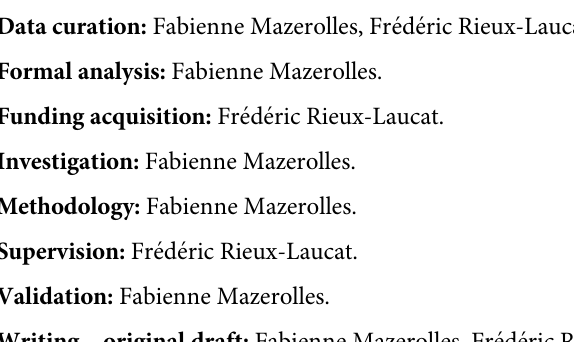
control (Iso) is shown for each protein (grey lines). Bars represent the means of all experiments for each proteins. (TIF) S5 Fig. TIGIT expression on activated T cells. A) Representative flow cytometry dot plots for cell proliferation on D5 of the co-culture. CTV-stained TEFFs were co-cultured with DCs-SEE in the absence (TEFFa) or the presence of CFSE-stained TREGs (TEFFb) with a TEFF:TREG ratio of 2:1. B) Representative histograms of TIGIT expression (solid black lines) on gated CTV-stained TEFFs in the absence of TREGs (TEFFa) or in the presence of TREGs (TEFFb) and on gated CFSE-stained TREG (TREGs). The TEFF:TREG ratio was 2:1. The isotype con- trol (Iso-APC) is shown for each population (grey lines). Lower panel: graphs of the geometric mean fluorescence intensity of TIGIT expression on gated, CTV-stained TEFFs (TEFFa and TEFFb) and on gated, CFSE-stained TREGs in independent experiments (n = 5 to 30, depend- ing on the sub-population studied). ���� p � 0.0001 in an M-W test. Bars represent the means of all experiments for each proteins.